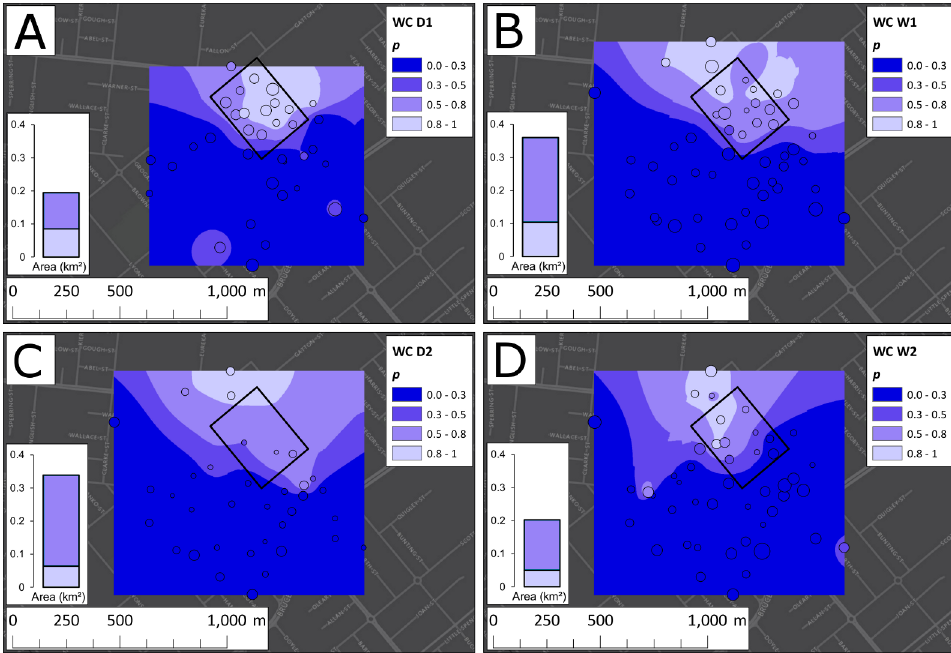
Fig 5. Ordinary Kriging of infection frequency ( p ) among traps at Westcourt (WC). Kriging was performed using an exponentialsemivariogram model and a 16-pointnearest-neighboursearch function for the first dry season (D1) (A), the first wet season (W1) (B), the second dry season (D2) (C), and the second wet season (W2). The central black polygondepicts the release zone. Trap locationsare plotted as circles atop each Kriging map and are sized by a logarithmicfunction of the trap yield from each season. To the left of each Krigingplot, a stacked column chart displaysthe areas enclosedby the p > 0.8 and p > 0.5 contours, showinga declinein the area of